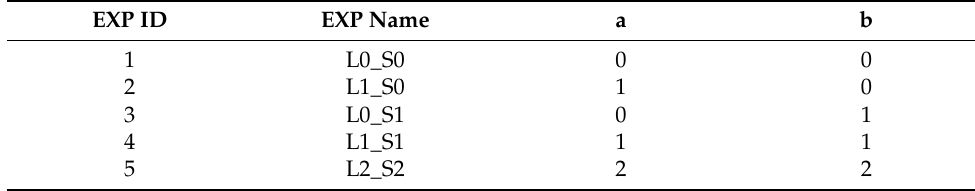
Table 1. Numerical experimental design in detail.